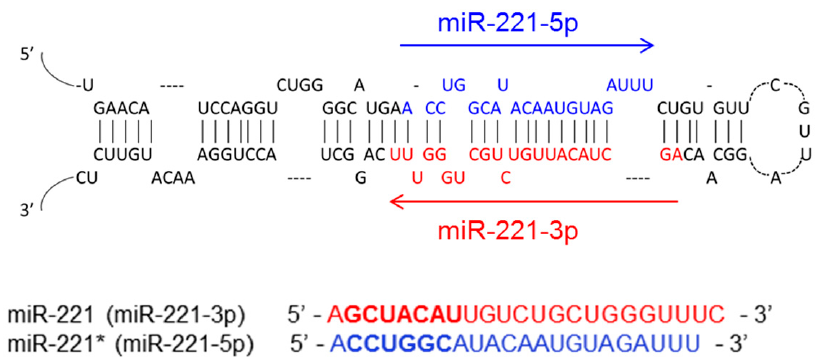
Figure 1. The sequences of miR-221 and miR-221*. Mature sequence of miR-221-5p is in blue, while miR-221-3p is shown in red. The seed sequence of the miRNA is highlighted.